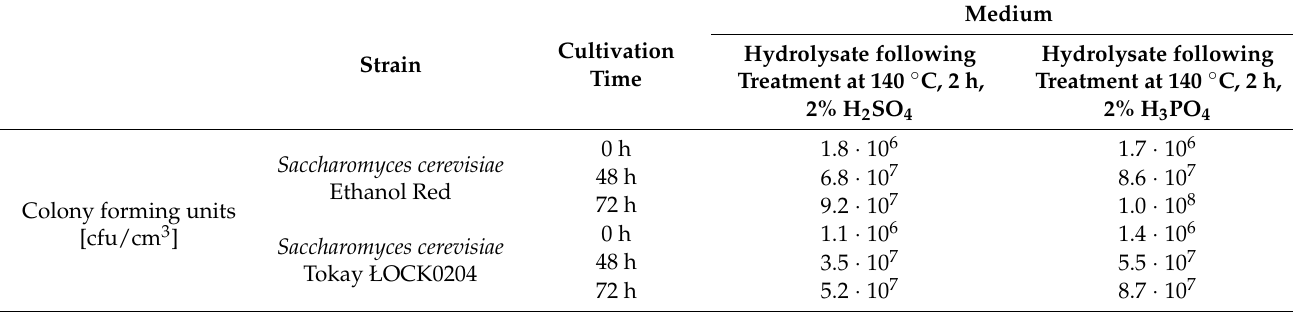
Table 2. Yeast cell